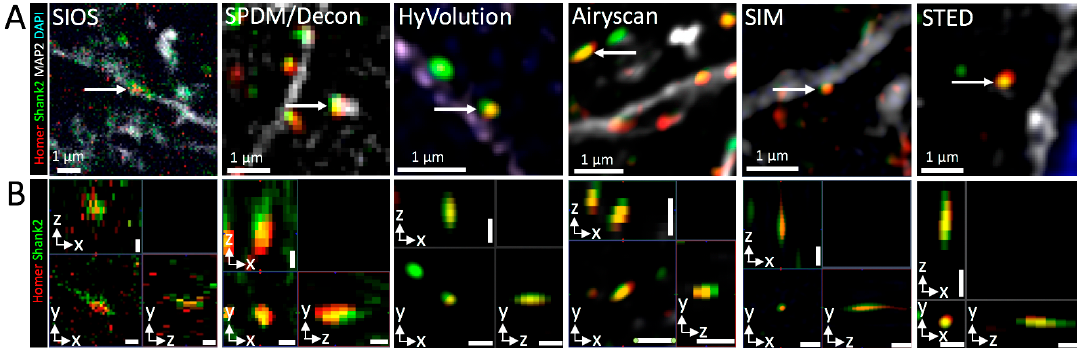
Figure 6. Comparison of various microscopy methods in 3D synapse imaging of mouse brain tissue. ( A ) shows single optical sections of the image stacks described in Figures 3 and 5 ((Mouse brain immunofluorescence labeling of Homer1 (Homer; red), Shank2/ProSAP1 (Shank2; green) and MAP2 (white); DNA counterstained with DAPI (blue)). Single focal accumulations of Homer and Shank2/ProSAP1, likely representing PSDs were selected from each section (white arrows) and displayed as orthogonal views in B . SIOS, structured illumination optical sectioning (ApoTome); SPDM, spinning disc confocal microcopy; SIM, structured illumination microscopy; STED, stimulated emission depletion. Please note, that 2D-SIM and 2D-STED was employed here, while the HyVolution and Airyscan stacks were deconvolved resulting in improved z-resolution. Bars, 1 µm ( A ) and 500 nm ( B ).